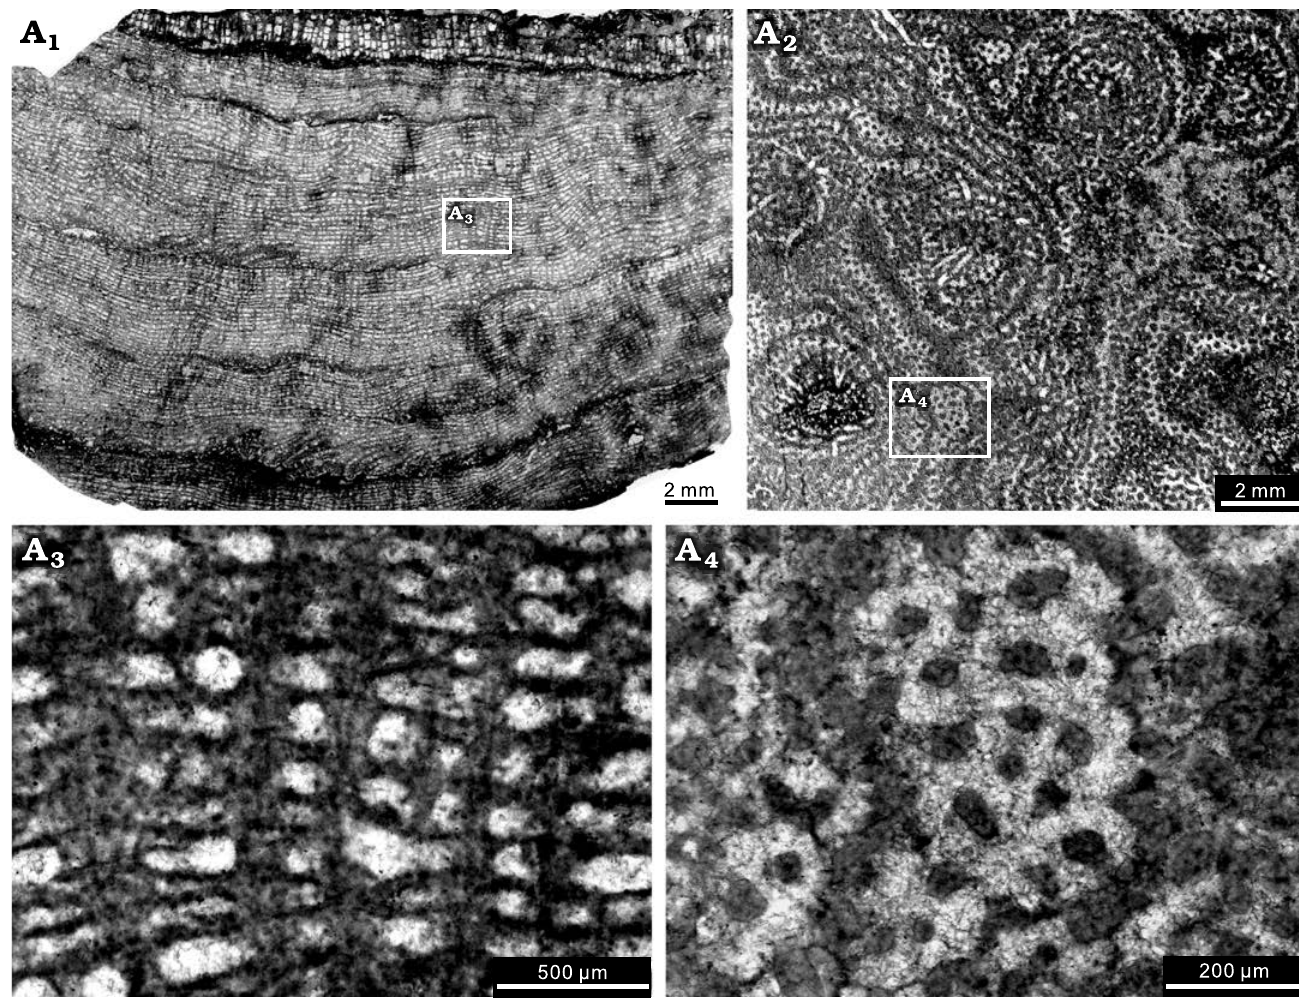
Fig. 5. Stromatoporoid Gerronostromaria grossum Dong, 1974, NIGP 177047, from the Jiwozhai reef, Jiwozhai Member, Dushan Formation, Givetian, Middle Devonian; Dushan, Guizhou, South China. A 1 , longitudinal section, note the well differentiated network constructed by thin laminae and pillars; A 2 , tangential section showing the distinct mamelons; A 3 , enlargement of A 1 , illustrating the common occurrence of the diagenetic “clinoreticular” micro- structure inside the continuous pillars; A 4 , enlargement of A 2 , showing the isolated